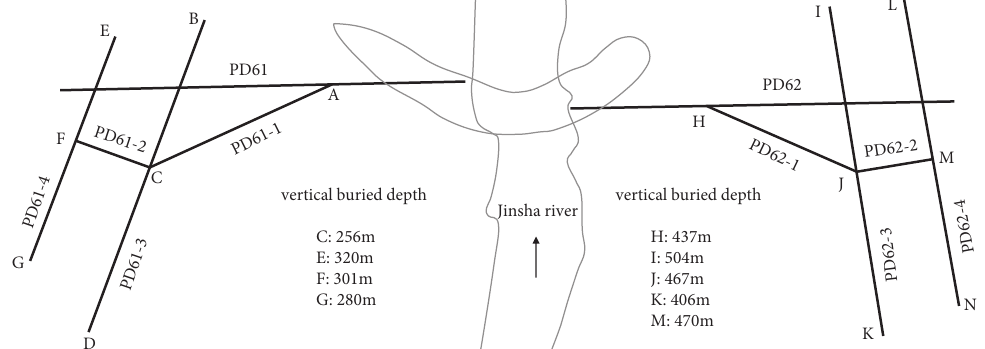
Figure 1: Distribution of exploration tunnels on the left and right bank.